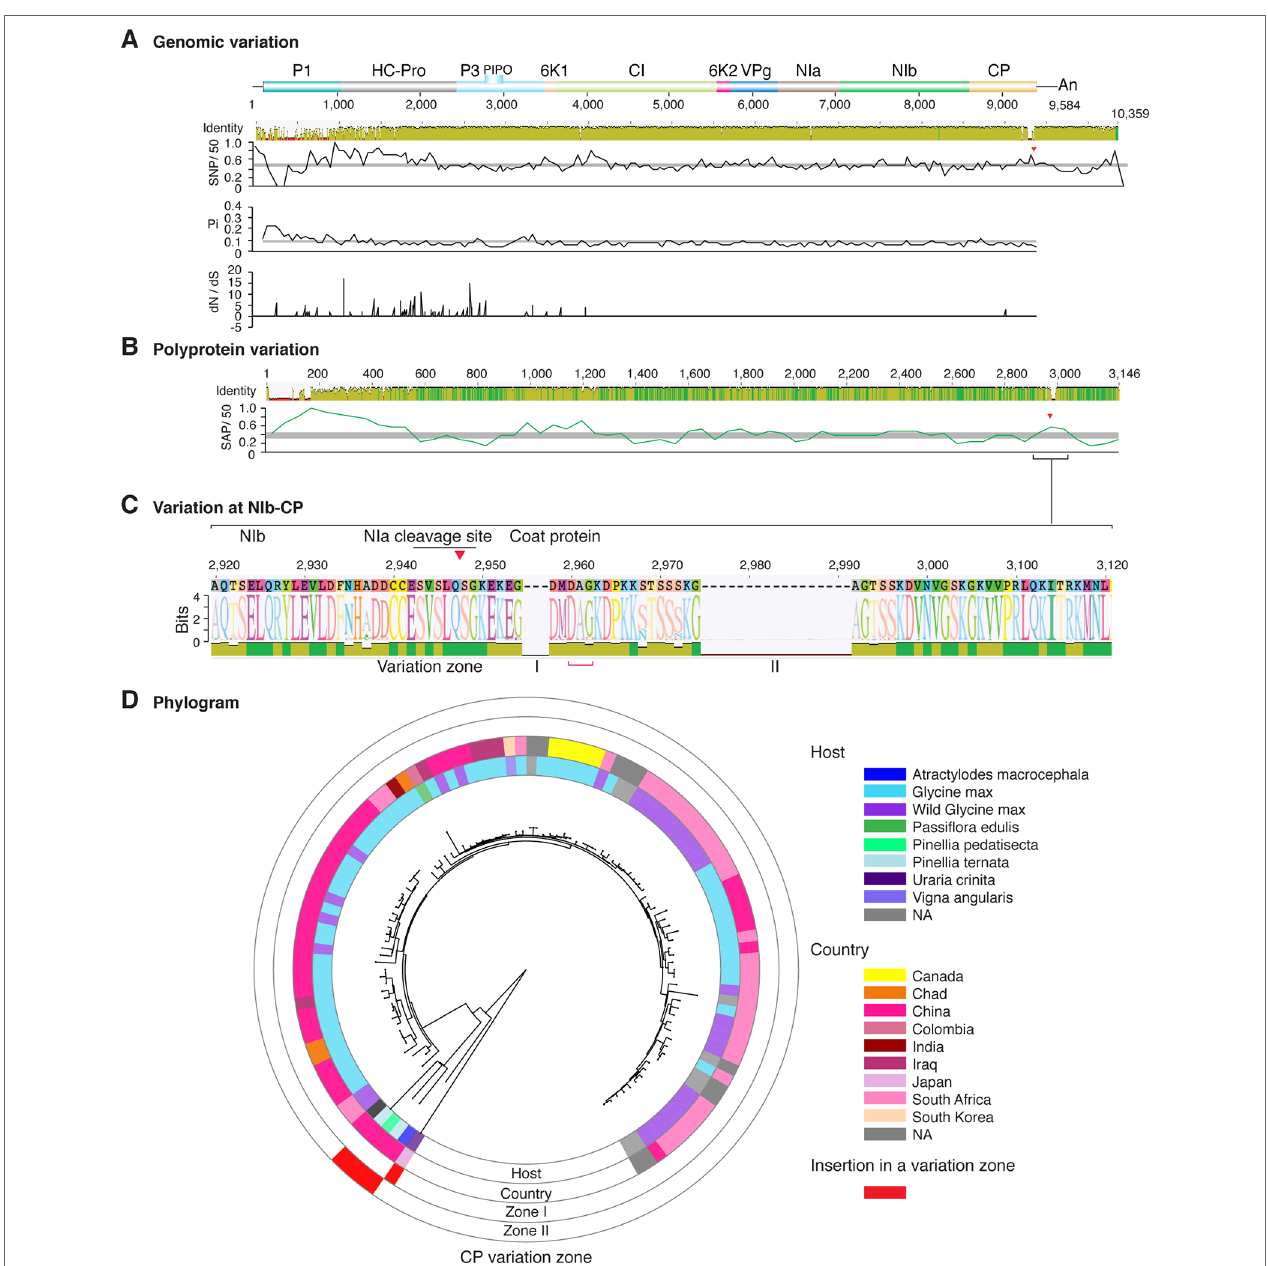
FiGUre 4 | Nucleotide and polyprotein variation in soybean mosaic virus. Genome organization is shown to scale using accession KY986929 as reference. Labels are as in Figure 2 .